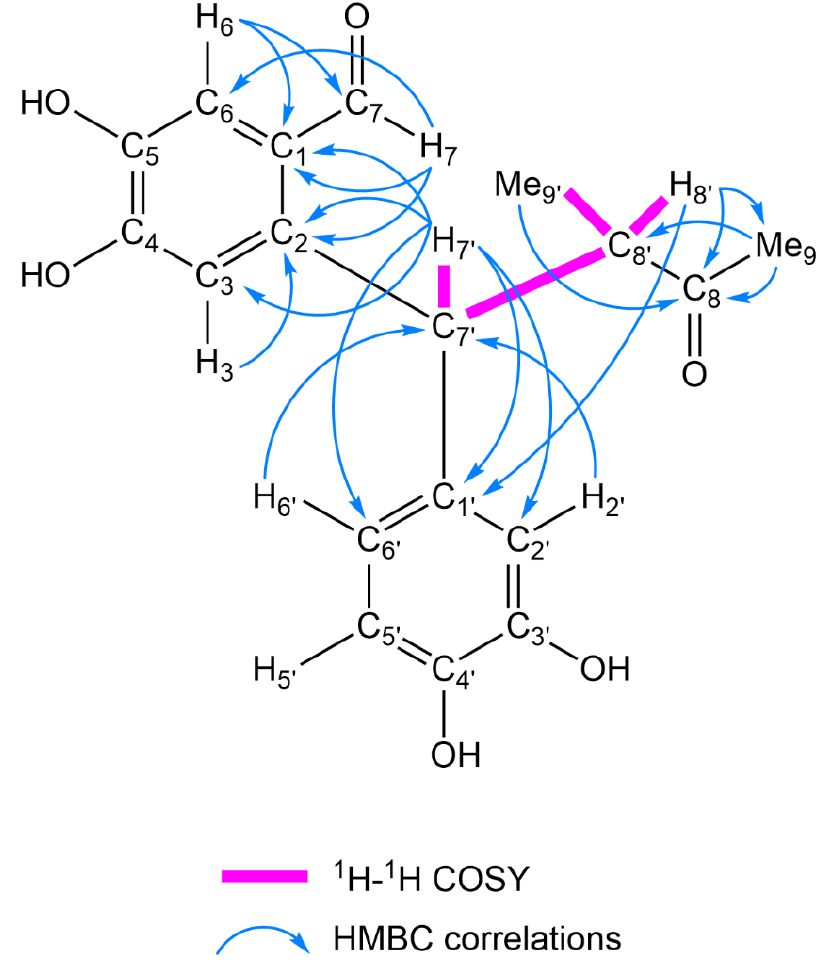
Figure 4. 1 H- 1 H COSY and key HMBC correlations of 5.